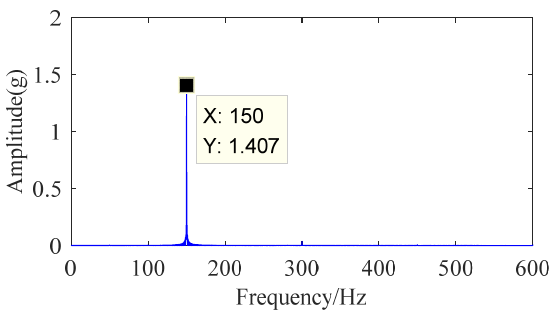
Figure 13. Vibration response of 304 stainless steel clamp with a 200- μ m-thick hard coating of Z r O 2 - PTFE under 150 Hz fixed-frequency excitation.